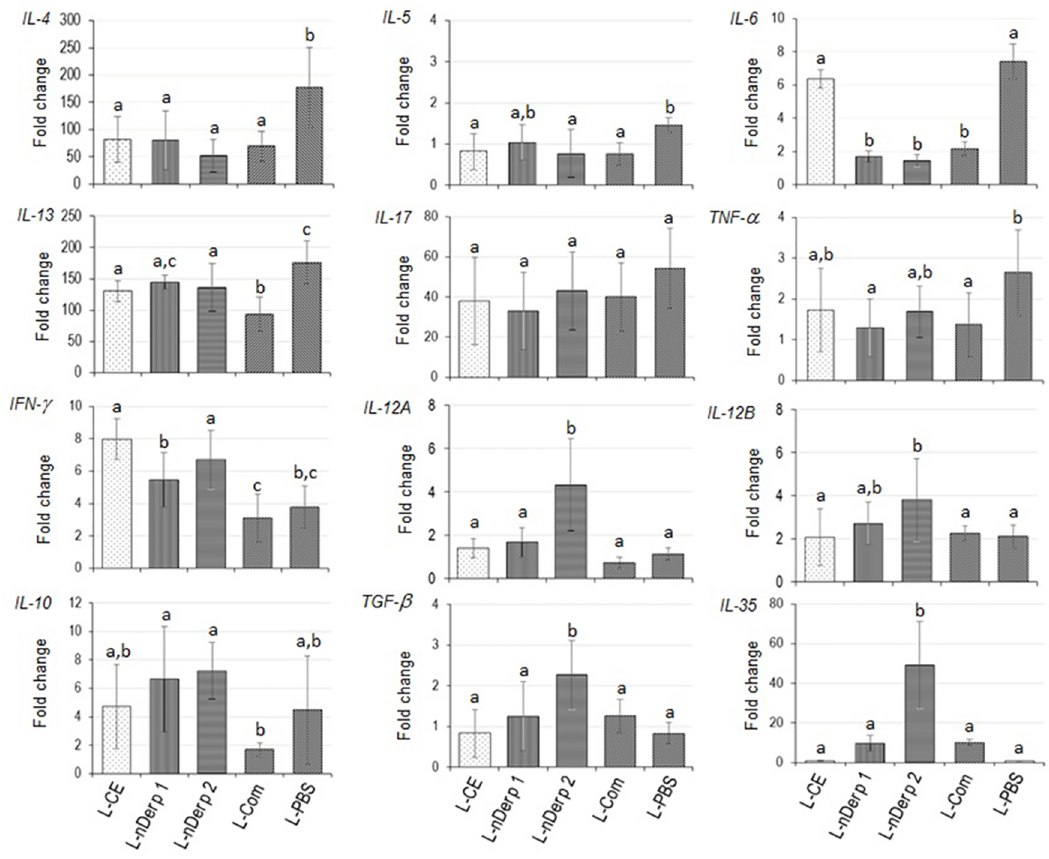
Fig 5. Cytokine expression profiles of Dermatophagoides pteronyssinus allergic mice after treatment with liposome-encapsulated vaccines/placebo and allergen provocation.